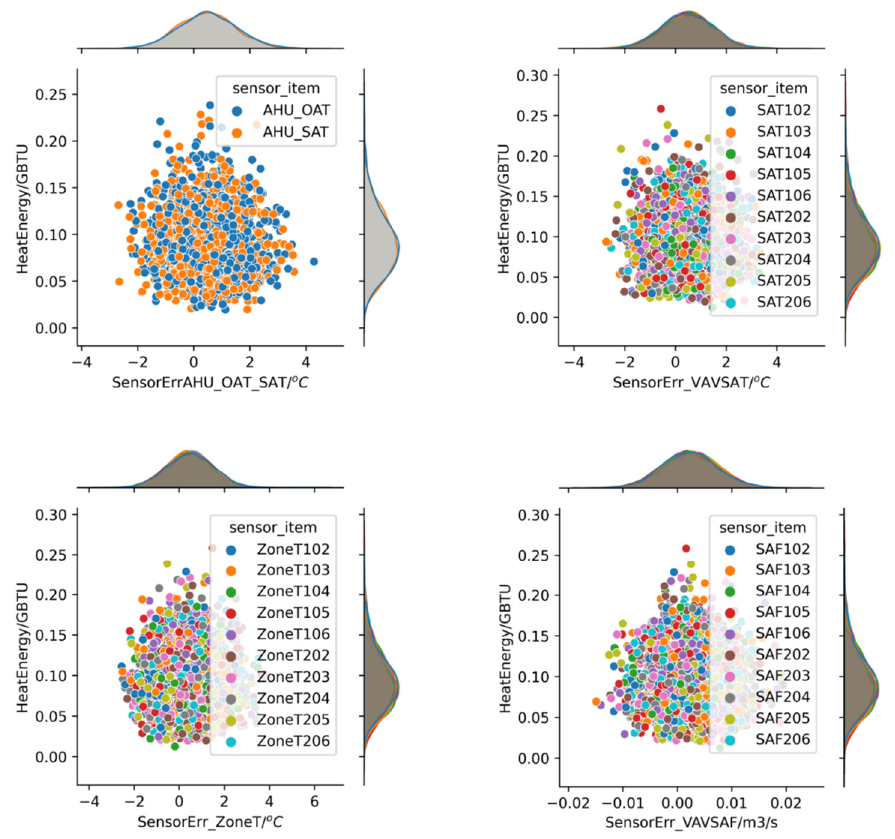
Figure 13. Heating energy and sensor errors.